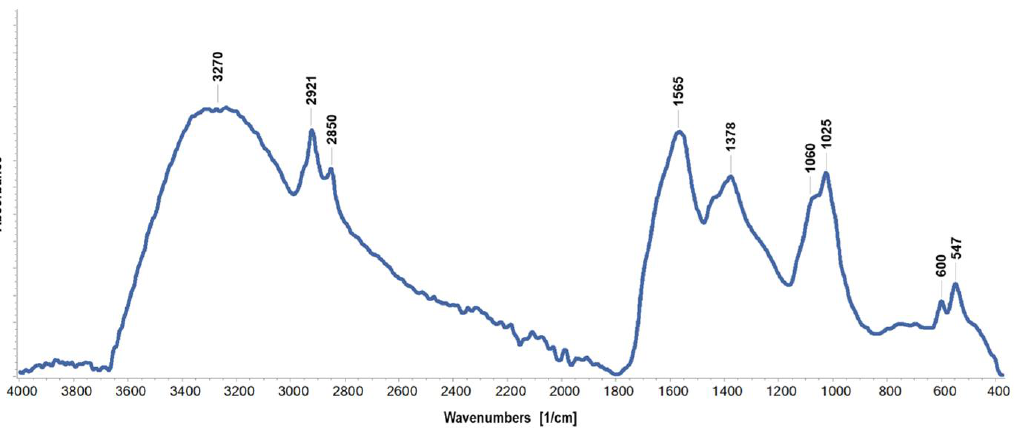
Figure 3. ATR-FT-IR spectra (4000 – 400 cm −1 ) of an archaeological sample from the cylindrical vessel.